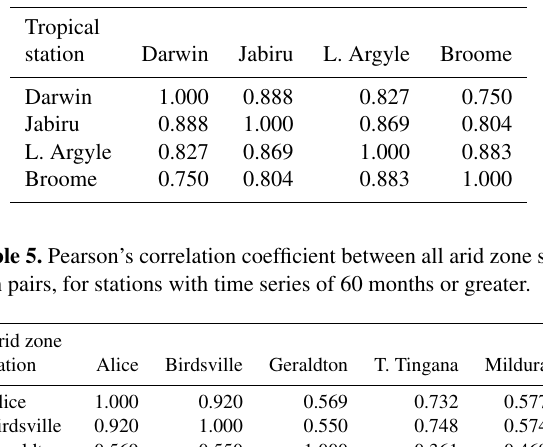
Table 4. Pearson’s correlation coefficient between all tropical sta- tion pairs, for stations with time series of 60 months or greater.